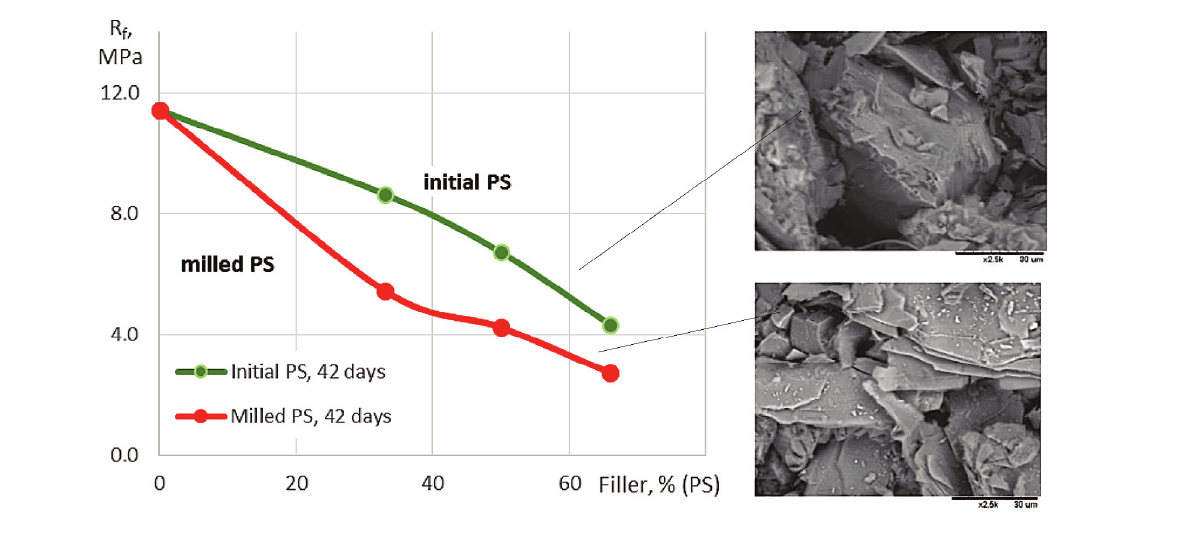
Fig. 7. Dependence of flexural strength on the amount of polarstone in the